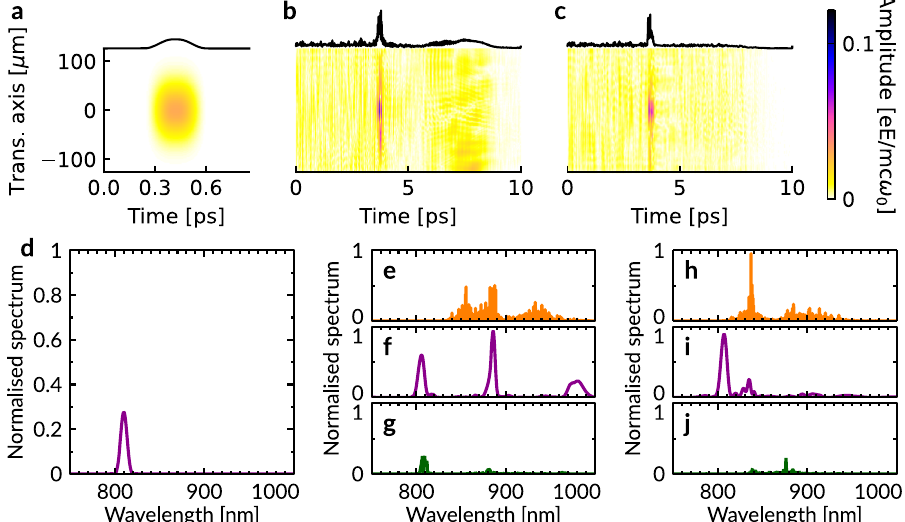
Fig. 4 2D simulation results. a Initial seed amplitude pro fi le. b , c Ampli fi ed seed fi eld envelopes after interaction with a pump beam with positive and negative frequency chirps, respectively. Pump back-scattering in front of the seed is not shown in full. The power spectrum of the initial seed is illustrated in d . Power spectra of the line-outs through the centre of the scattered signals are shown in e – g , for positive chirp and h – j , for negative chirp: e , h spectrum of the signal scattered in front of the seed; f , i spectrum of the ampli fi ed seed; g , j spectrum of the signal scattered into the trailing region behind the seed. All spectra are normalised by the largest peak value from the spectrum shown in h .